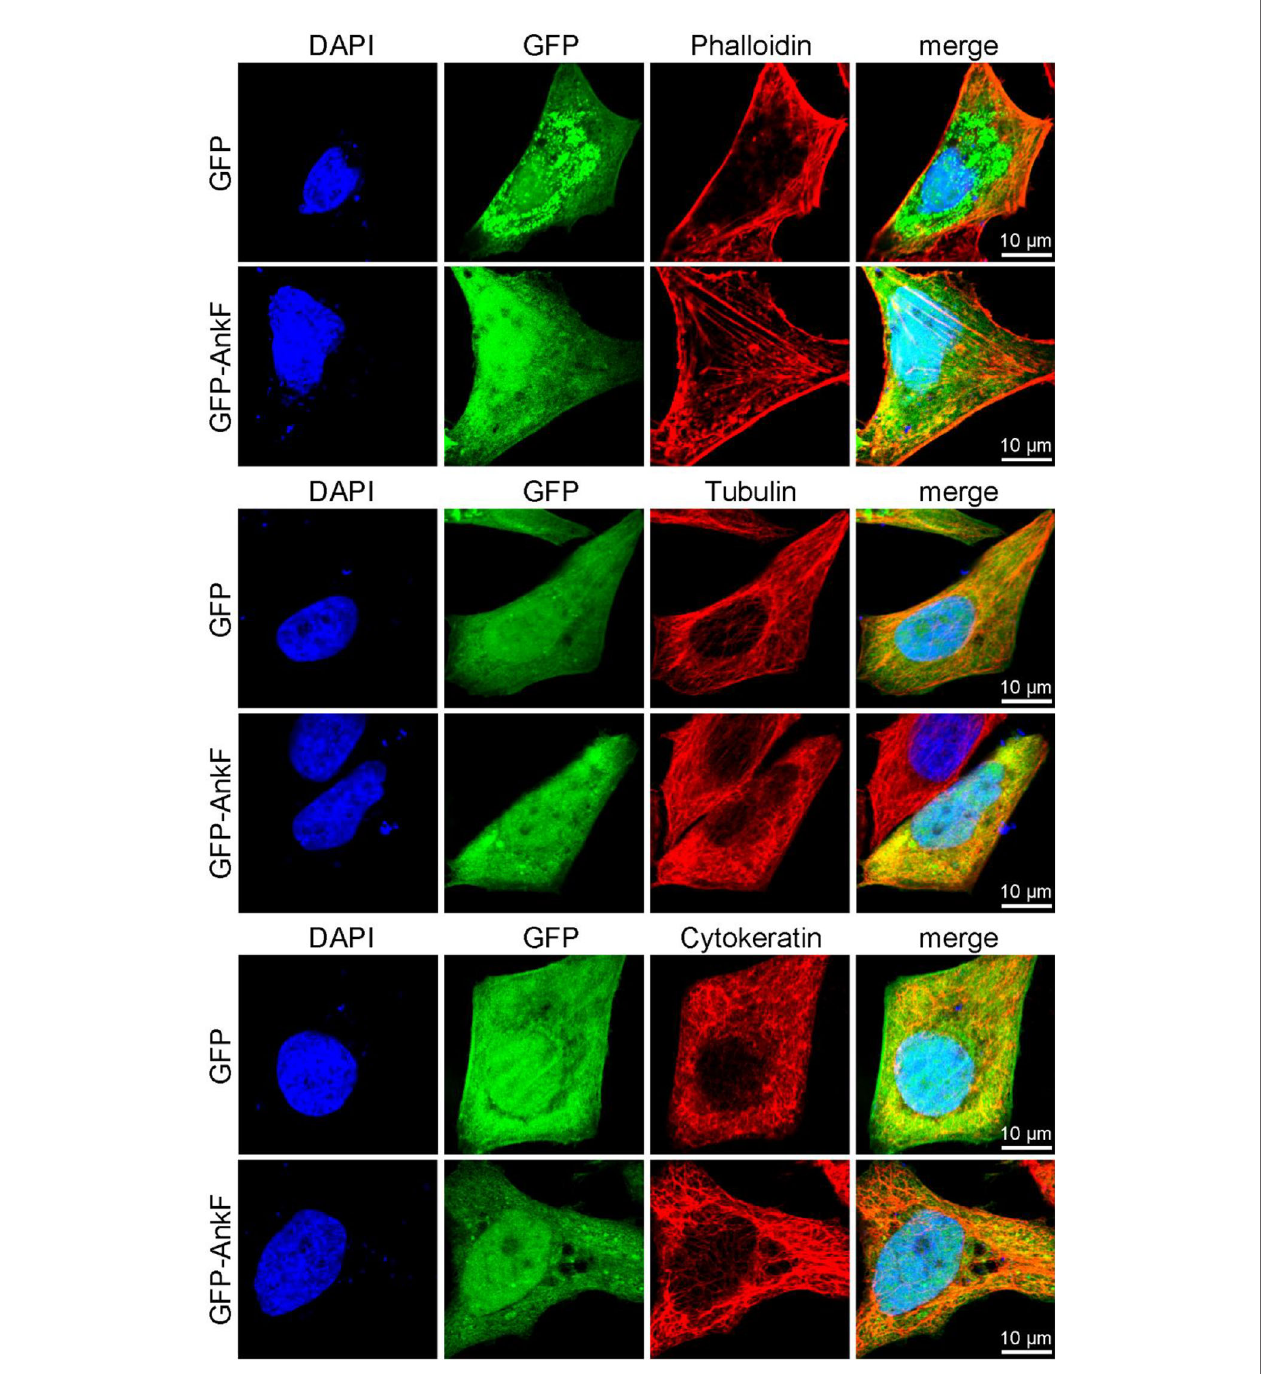
FIGURE 11 | Cytoskeletal fi laments are not modi fi ed by AnkF expression. HeLa cells were transiently transfected with pGFP alone or with pEGFP-AnkF (green). 24 h post-transfection, cells were fi xed and stained with Phalloidin-Alexa647 for actin, or with tubulin- and cytokeratin 18-speci fi c antibodies by indirect immuno fl uorescence (red). Nuclei and bacterial DNA were stained with DAPI (blue). Cells were visualized using LSM. Representative images from two independent experiments are